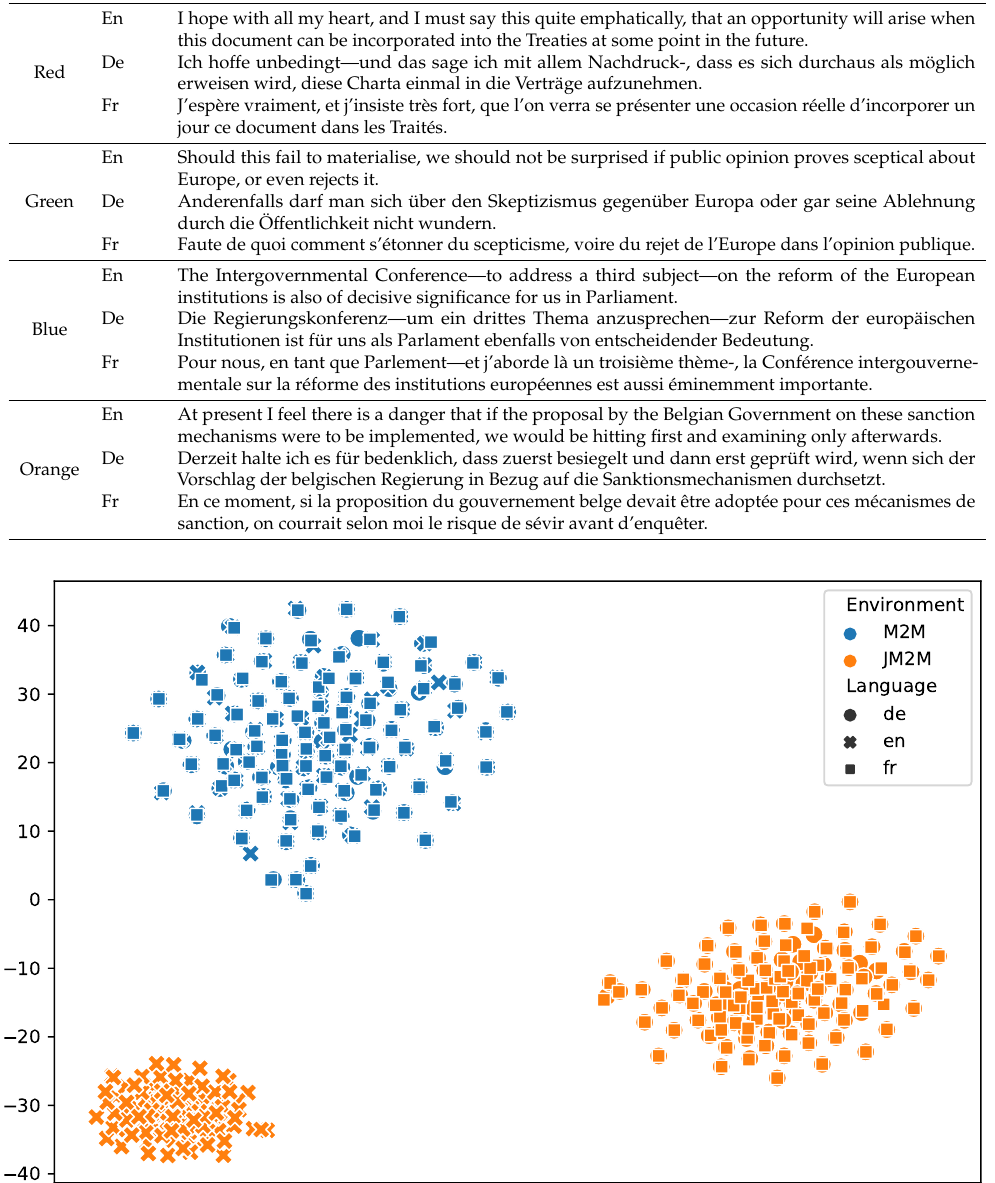
Table 1. Multi-parallel sentences used for interlingua visualization . Color Lang.